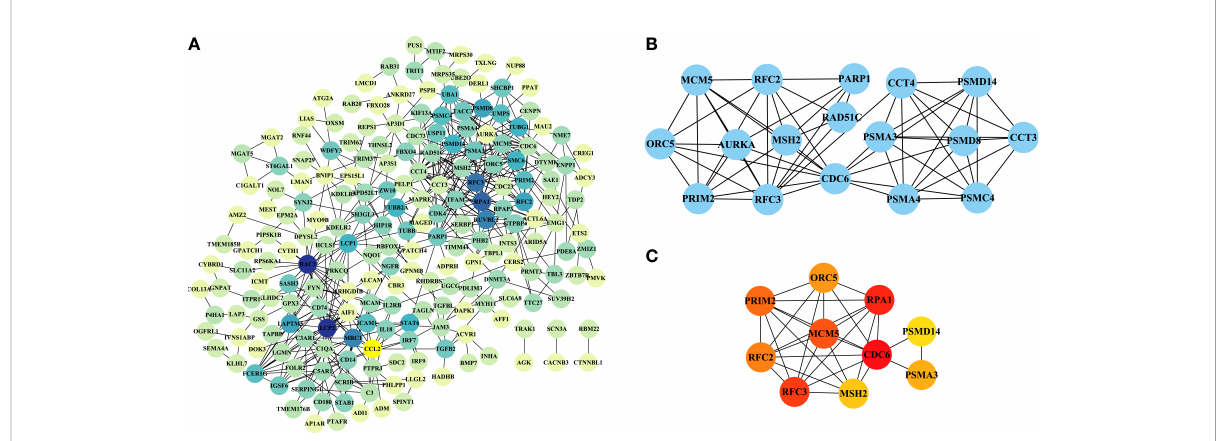
FIGURE 8 PPI network analysis of DEGs in PNA mice. (A) A PPI network with 211 nodes and 492 edges was constructed using Cytoscape software. (B) The top module results of MCODE PPI analysis. (C) The ten genes with the greatest linkage were selected for treatment as hub